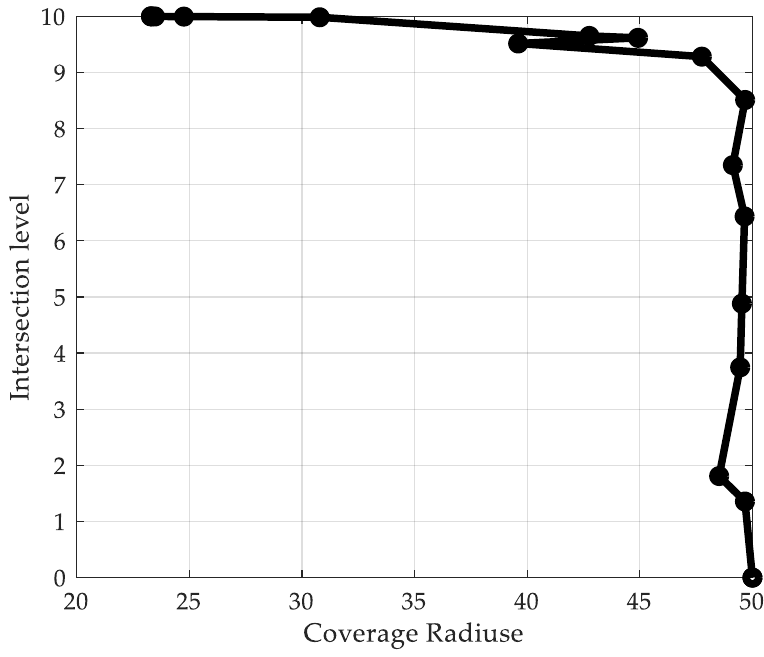
Figure 7. Values of optimal combinations of coverage radius and intersection level.